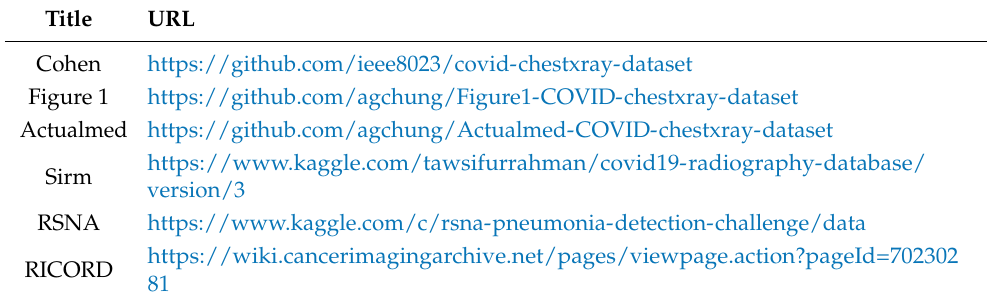
Table 2. COVIDx V8A dataset sources.